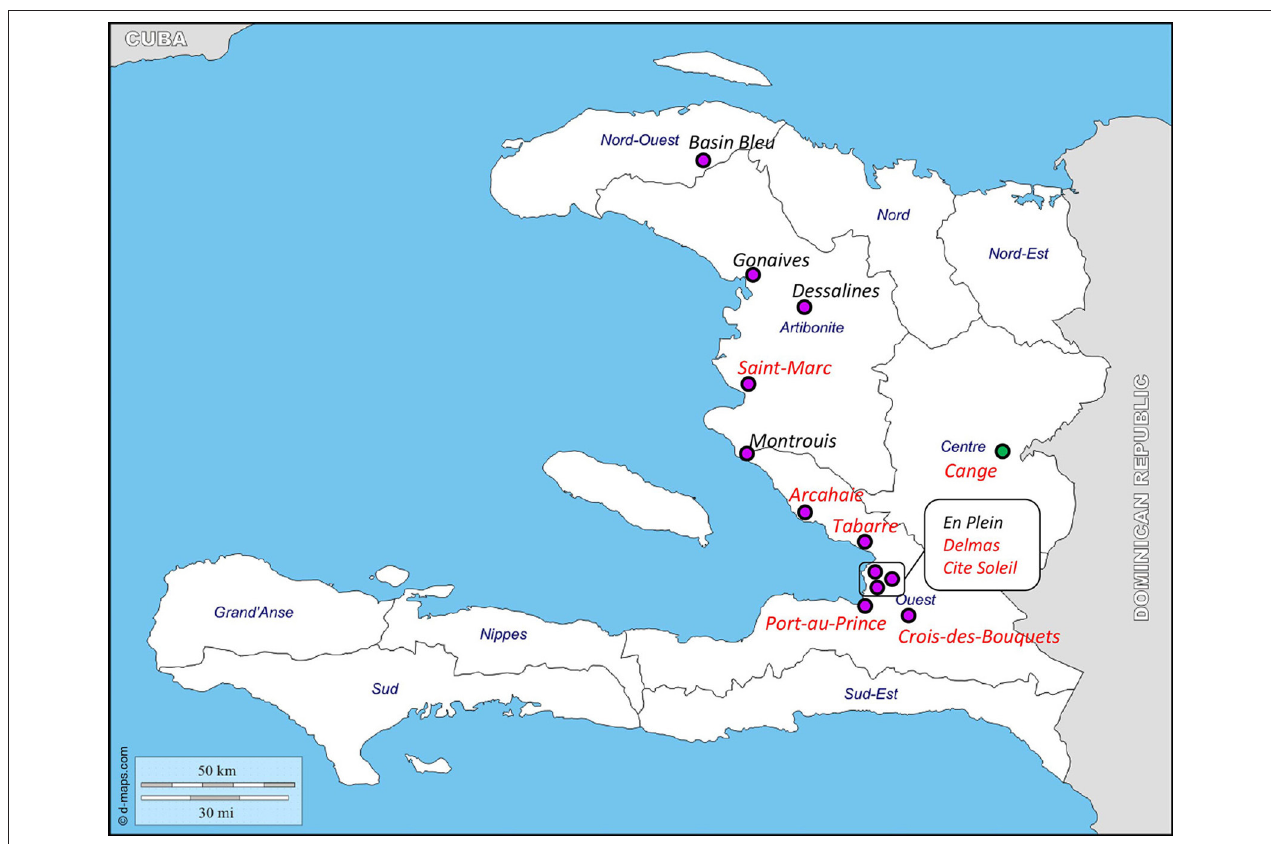
FIGURE 4 | Distribution of pSDH-1 and pSDH-2 in Haiti. Purple and green circles indicate sites where clinical and environmental isolates were collected, respectively, in the Departments of Nord-Ouest, Artibonite, Ouest, and Centre. Red indicates districts where pSDH-1 and/or pSDH-2 were detected (see Table 2 ). Original figure was downloaded from http://www.d-maps.com/carte.php?num_car=5262&lang=en, according to the website terms and conditions of